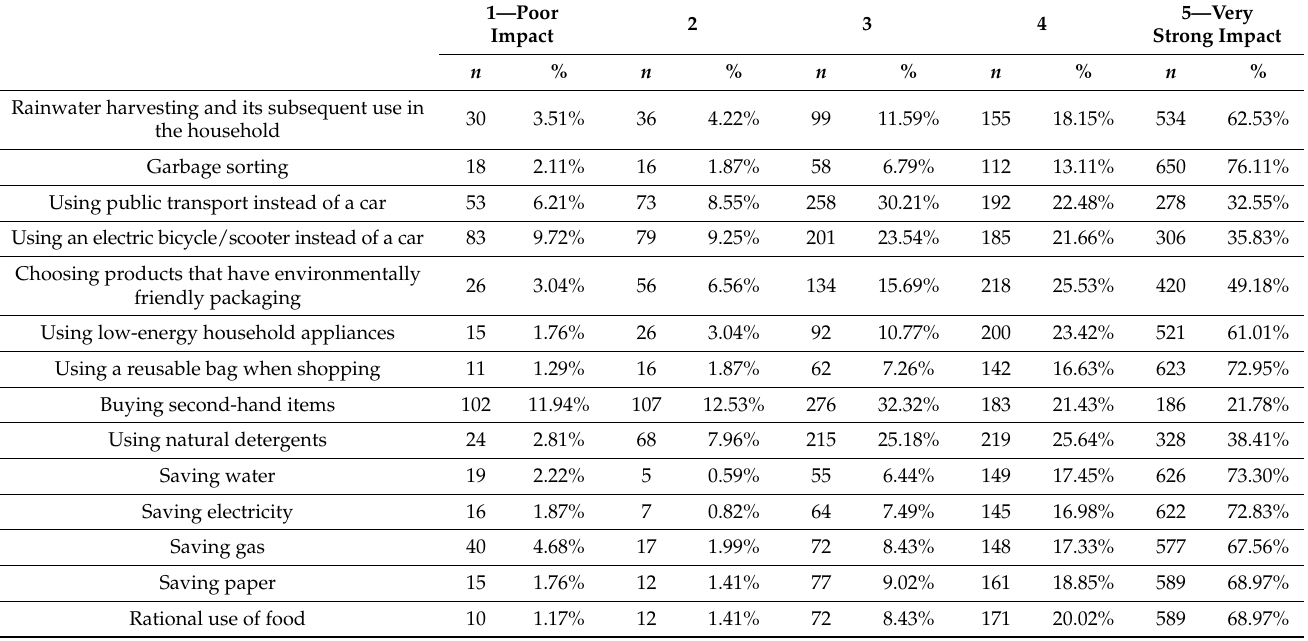
Table 7. Respondents’ opinions on the degree of positive impact of particular pro-ecological behaviors on the